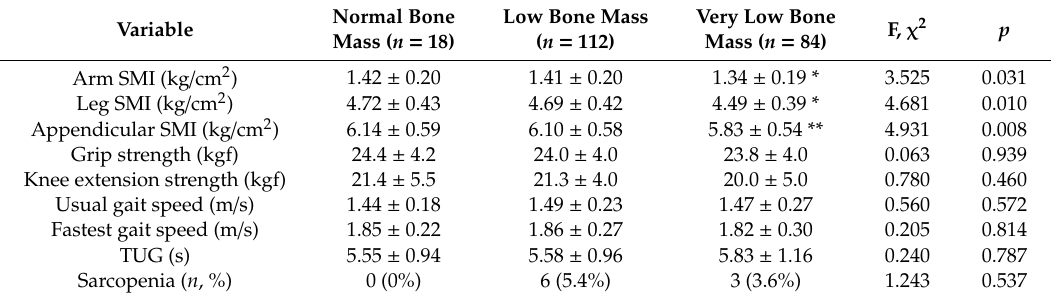
Table 2. Comparison of skeletal muscle index (SMI), muscle strength, physical performance, and sarcopenia between the normal, low, and very low muscle mass